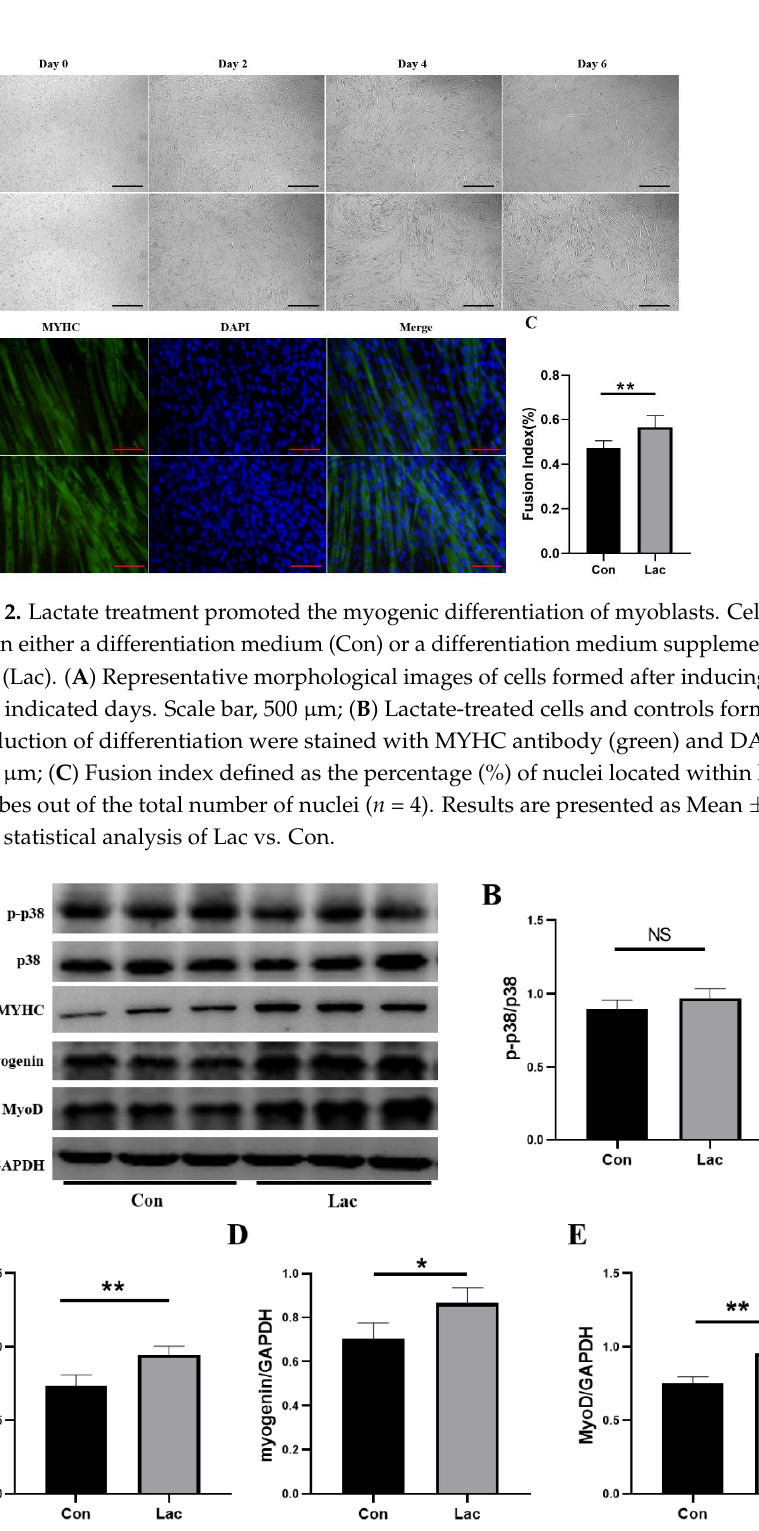
Figure 3. Lactate treatment promoted expressions of myogenic differentiation-related proteins in C2C12 myotubes. Myoblasts were differentiated either in a differentiation medium (Con) or a differentiation medium supplemented with 5 mM lactate (Lac). ( A ) Expressions of p-p38 (Tyr182), MyoD, myogenin, and MYHC in Lac and Con groups were analyzed by Western blot; ( B – E ) Gray value analyses corresponding to Panel ( A ) ( n = 3). Results are presented as Mean ± SD. * p < 0.05, ** p < 0.01, NS: Not Statistically, for the statistical analysis of Lac vs. Con.